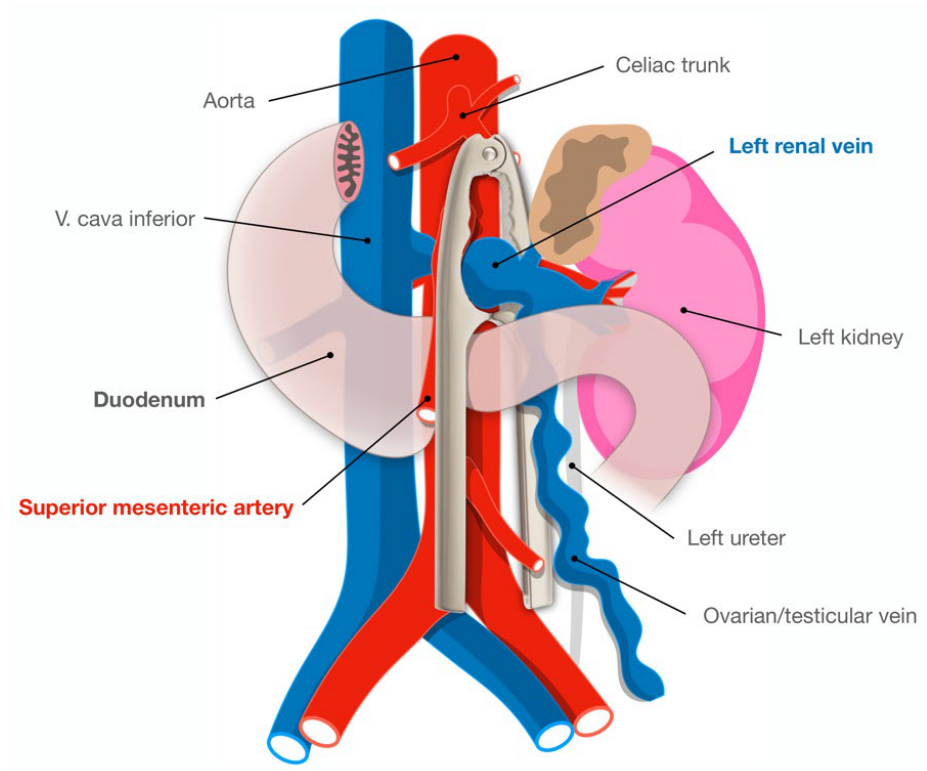
Figure 1. Illustration of the aortomesenteric angle in relation to the left renal vein and the terminal duodenum, tangling the two simulates the shape of a nutcracker (overlaid).